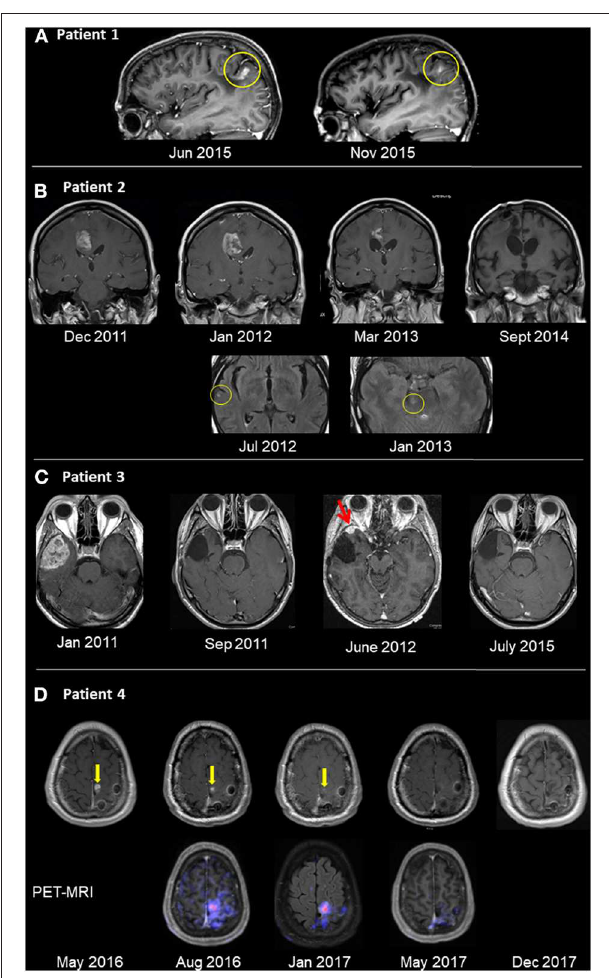
FIGURE 1 | Radiological follow-up of GBM tumors treated with oncolytic virotherapy. (A) Patient 1 was diagnosed with GBM in 7/05 and underwent total surgical resection in 8/05. OV therapy was initiated in 5/06 and given for 3.5 years, after which patient remained with NED for 6.0 years. Recurrence in the left parietal lobe appeared on sagittal T1 contrast-enhanced images in 6/15 (left). The patient improved clinically after renewing OV alone. Five months thereafter, lesion shrinkage was observed (right). (B) Patient 2 was diagnosed with GBM in 10/10, underwent surgical resection and chemoradiotherapy. Relapse occurred (12/11) in the right frontal lobe (left image top row, T1 contrast enhanced images), with clinical deterioration. OV therapy was initiated. Follow-up imaging showed shrinkage until disappearance of the pathological enhancement. Concurrent to OV therapy and shrinkage, multiple scattered FLAIR hyperintense foci (with and without enhancement) were seen (bottom row, FLAIR images, yellow circle), possibly an immune-mediated response. (C) Patient 3 was diagnosed with a right temporal lesion (1/11; left image, T1 post contrast), underwent surgical resection and chemoradiotherapy, and no residual tumor mass was seen (9/11). Relapse occurred (6/12; red arrow), and following a second resection, OV therapy was initiated. The patient has no residual tumor (7/15; right image) and has remained with no radiological or clinical evidence of disease. (D) Patient 4 was diagnosed with GBM (10/15) and underwent resection and chemoradiotherapy. Following relapse in the surgical bed (5/16; yellow arrow, left image of T1 contrast enhanced images), OV was initiated. The focus of pathological enhancement decreased in size until disappearance (1/17). Concurrent PET-MRI images (bottom row) showed hypermetabolic activity even while Gd enhancement was decreasing.